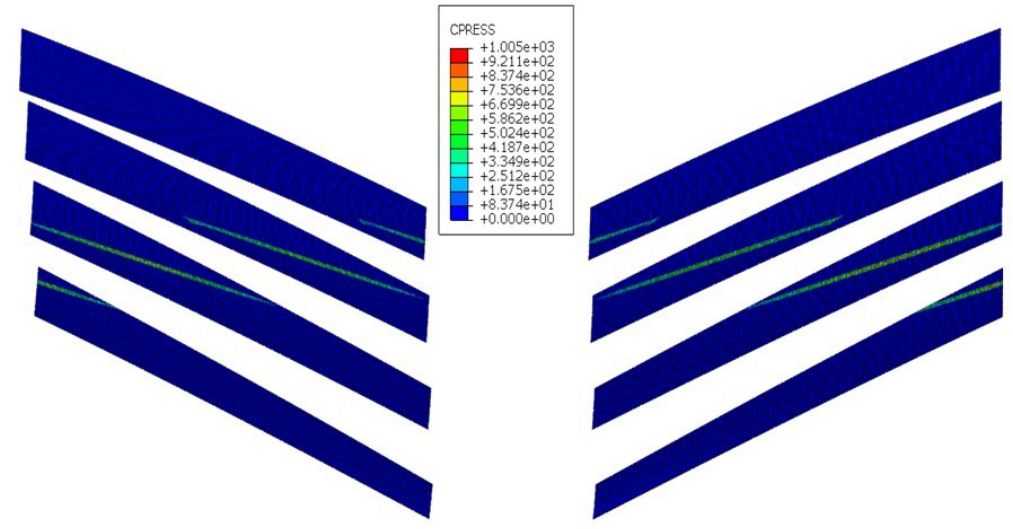
Figure 22. Contact stress cloud diagram of the modified tooth surface.